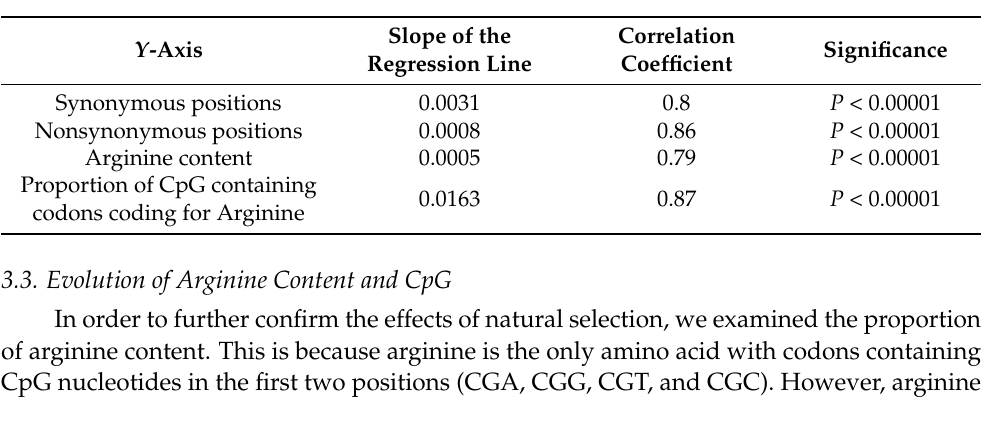
Table 1. Correlation coefficient and significance of relationships with the divergence times between SARS-CoV-2 and other